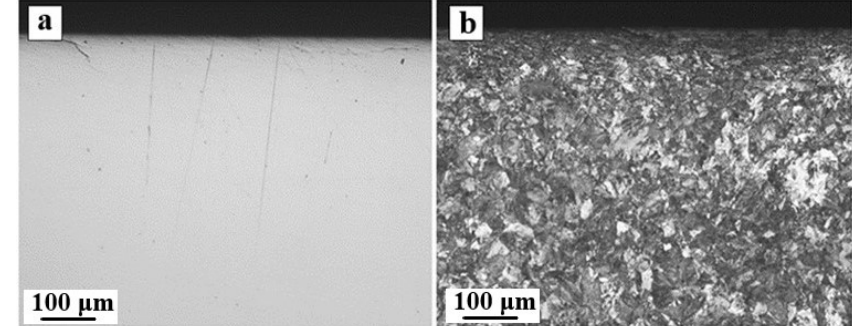
Figure 2. Structure of rail tread surface; a – unetched metallographic section; b – etched metallographic section.